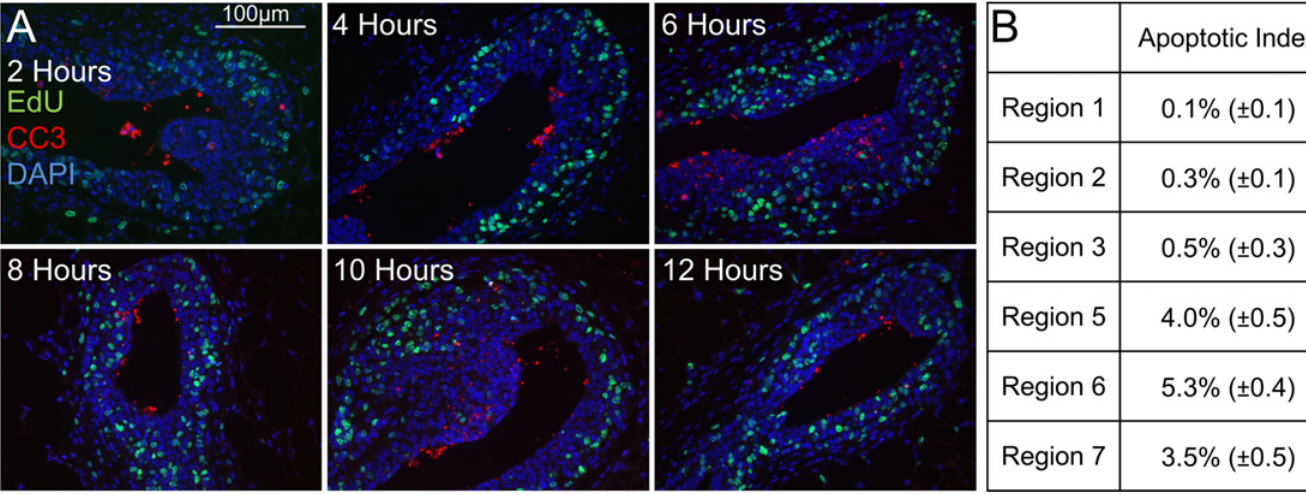
Fig 2. Determination of proliferation rate and cell cycle dynamics. Proliferation rates were analyzed by performing a dual labeling experiment with thymidine analogs EdU and BrdU. Mice were given a pulse of EdU at time “ 0 ” , then pulsed with BrdU every 2 hours for 24 hours. Mice were harvested 2 hours after pulsing with BrdU. A) Representative images of TEBs from each time point stained for EdU and BrdU incorporation. B) Quantification of EdU and Brdu single and double-positive populations throughout the time course indicate an S phase duration of 6 hours and total cell cycle time of 16 hours (n = 3 mice, 12 glands, 10 TEBs). See also S3 Fig.